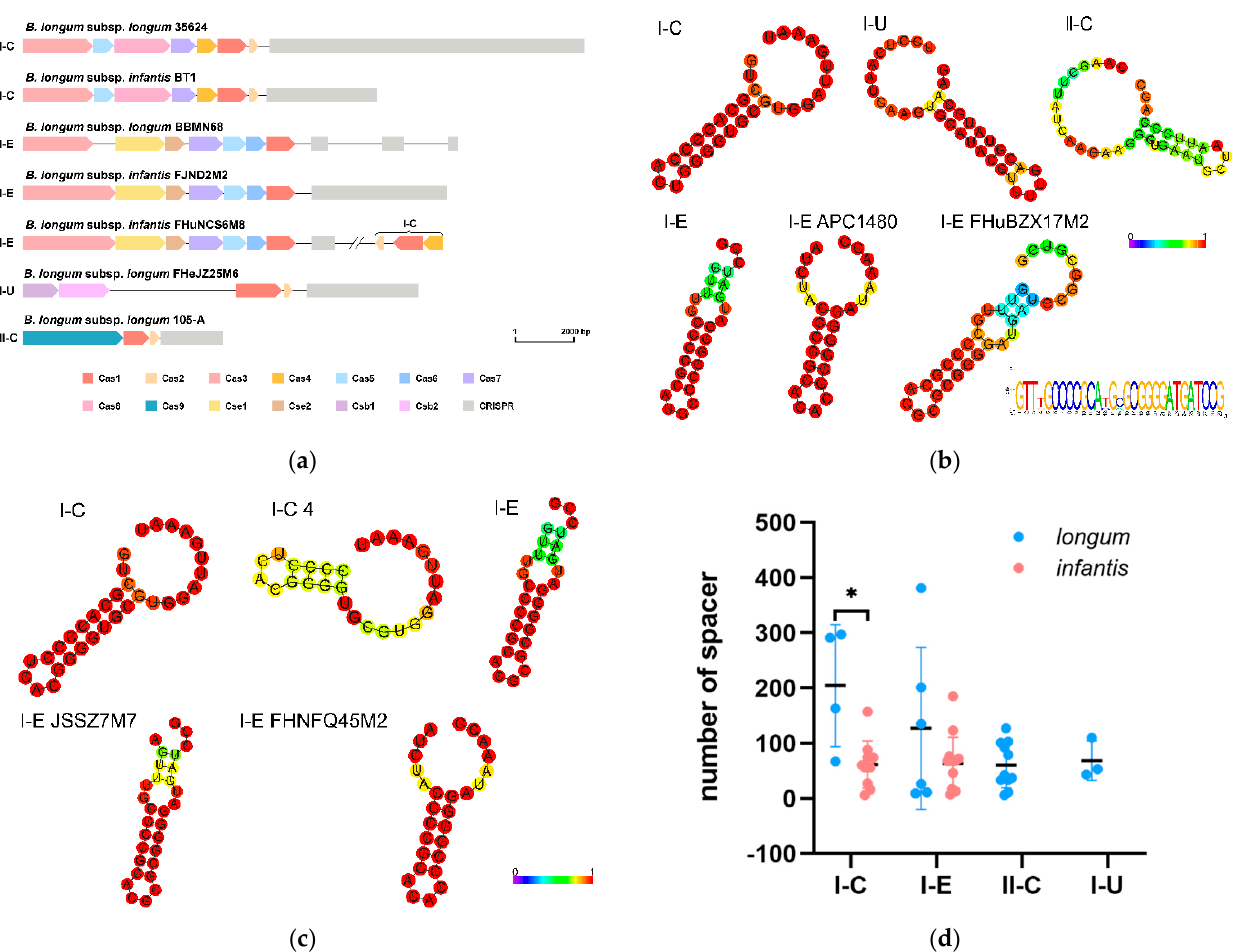
Figure 7. The characteristics of B. longum CRISPR: ( a ) CRISPR loci in B. longum . ( b ) Predicted RNA secondary structure for repeats of B. longum subsp. longum and repeat sequences shared by four type I-E strains. The height of the letter indicates the frequency of the corresponding base at that position. ( c ) Predicted RNA secondary structure for repeats of B. longum subsp. infantis . The minimum free energy (MFE) structure was coloured by base-pairing probabilities. ( d ) Number of B. longum spacers. The significant difference was evaluated by t -test. * p < 0.05